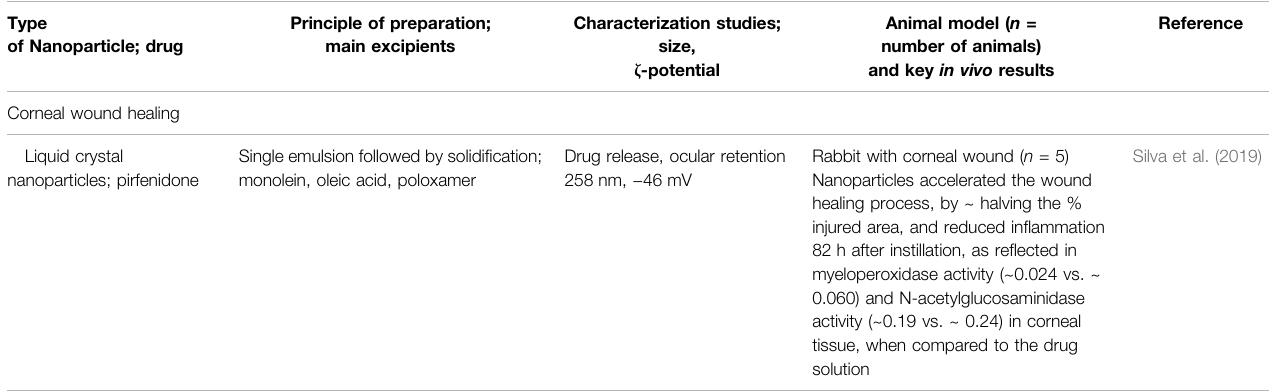
TABLE 4 | ( Continued ) Summary of in vivo studies on nanoparticle-based systems used for drug delivery to anterior segment of the